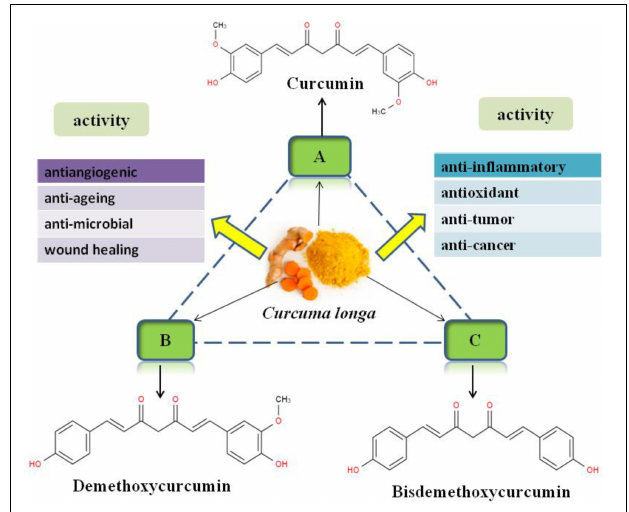
FIGURE 1 | Chemical structures of curcuminoids and their main biological